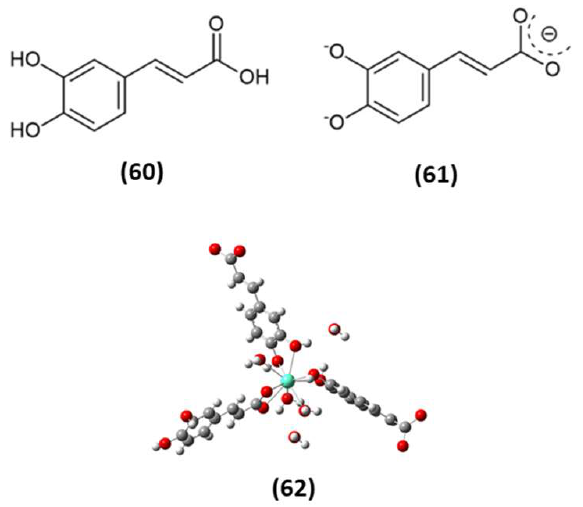
Figure 7. ( a ) % of reduction in oxidative stress by Eu 3+ /CFA complicated at 50, 500, and 1000 mol dm −3 ; ( a ) CFA and Eu-CFA antioxidant properties assays at the identified concentration level ( b ) FRAP assay assessment of reducing possibility; ( c ) proportion of inhibition of ABTS •+ cation radi- cals; ( d ) CUPRAC test findings demonstrated as Trolox offerings [mol • dm 3 ]. Mean results from three independent tests ± SD are shown. Reproduced from the permission of ref. [139]. MedetalibeyogluH (2022) studied and synthesized the antioxidant activity of (EPM)2-ethoxy4-[(5-oxo-3-phenyl-1,5-dihydro-1,2,4-triazol-4-ylimino)-methyl]-phenyl-4- meth oxybenzoate (Scheme S5). The tested EPM (63) material was positively